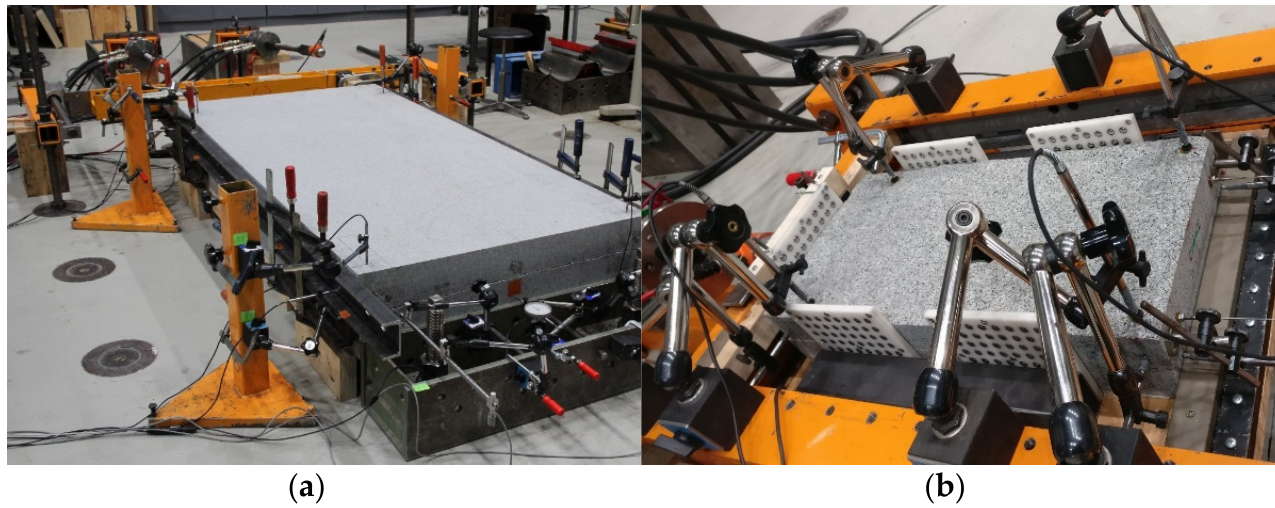
Figure 4. Push shear test setup for the large sample: large sample 2000 mm × 1000 mm ( a ), and medium sample 500 mm × 250 mm ( b ).